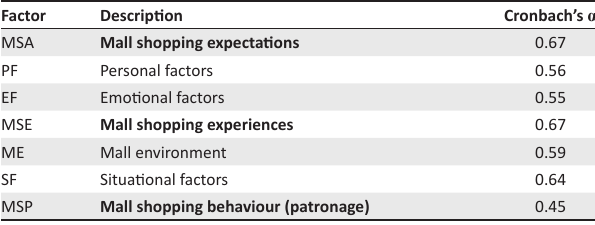
TABLE 4: Item analysis results.